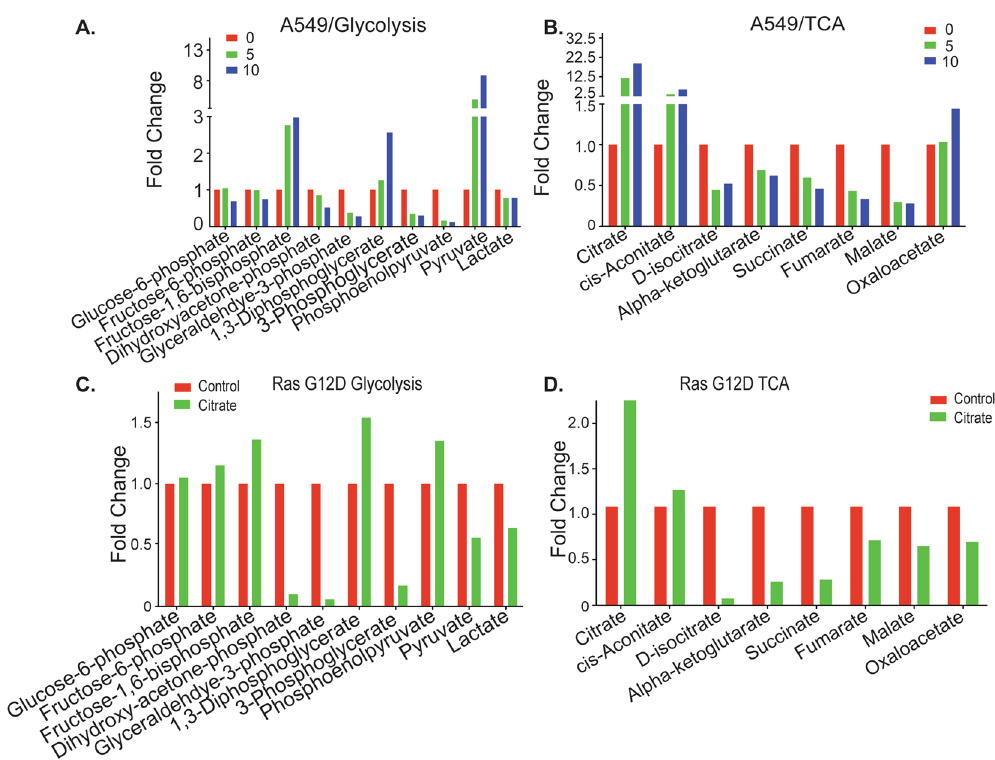
Figure 6. Citrate treatment induces eIF2 α expression and activates PTEN pathway. Cells treated with or without citrate for 72 hours and equal amount of protein were subjected to SDS-PAGE. ( A ) Citrate treatment increases e-IF2 α activity. The full-length blots are presented in Supplemental Figure S16. ( B ) Citrate treatment increases the active form of PTEN activity in A549 cells. The full-length blots are presented in Supplemental Figure S17. ( C ) Citrate treatment increases the active form of PTEN in a macrophage (THP1) cells. The full- length blots are presented in Supplemental Figure S18. ( D ) Knockdown of PTEN inhibits e-IF2 α expression in MCF-10A cells. The full-length blots are presented in Supplemental Figure S19.